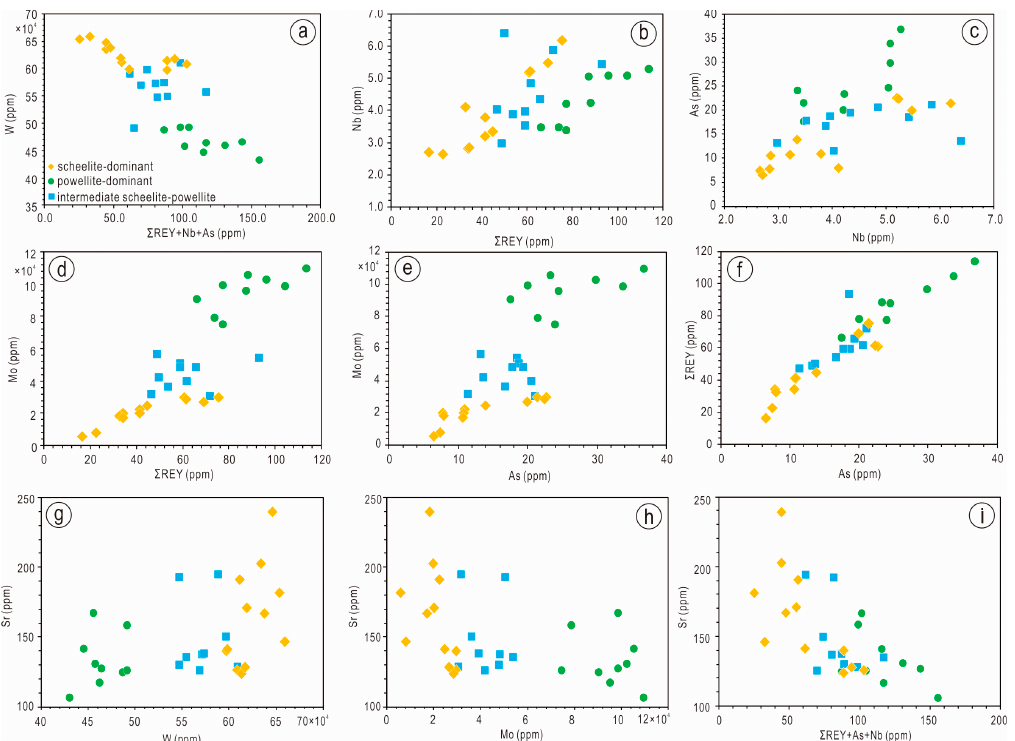
Figure 5. Binary plots showing trace element correlations in scheelite-powellite. ( a ) W vs. Σ REY + Nb + As; ( b ) Nb vs. Σ REY; ( c ) As vs. Nb; ( d ) Mo vs. Σ REY; ( e ) Mo vs. As; ( f ) As vs. Σ REY; ( g ) Sr vs. W; ( h ) Sr vs. Mo; ( i ) Sr vs. Σ REY + As + Nb.